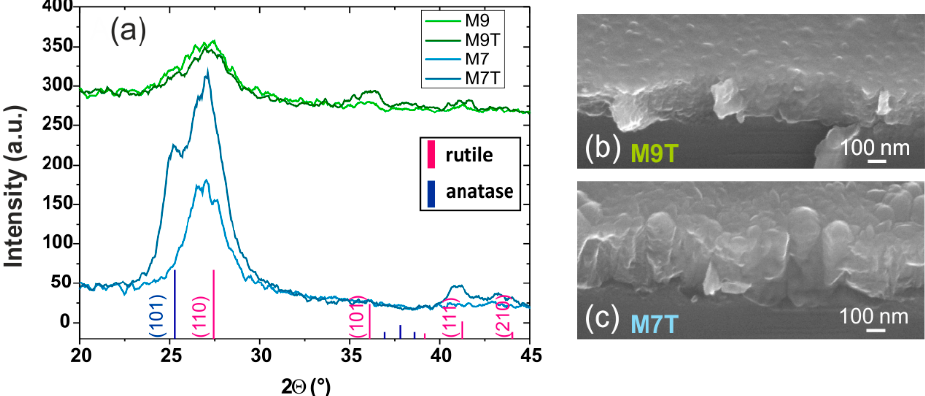
Figure 5. ( a ) XRD pattern evolution with film thickness for the M9 and M7 conditions and corre- sponding layer SEM images ( b , c ), respectively.